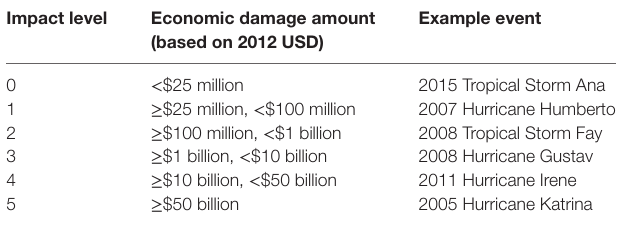
TaBle 2 | Hurricane Impact Level ranking system (Pilkington and Mahmoud, 2016).